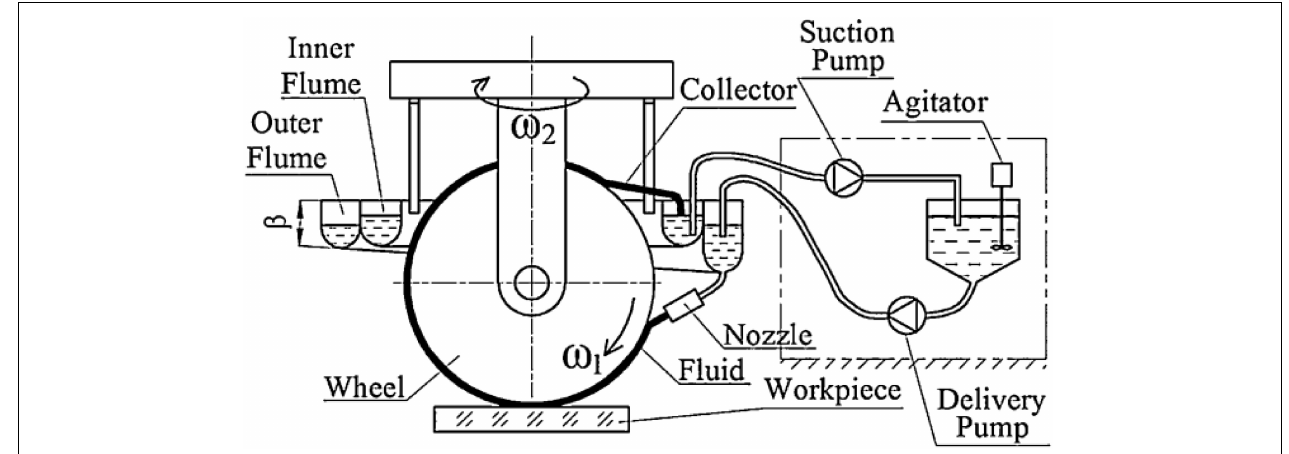
FIGURE 8 | The circulatory subsystem of DRMRF tool (Wang Y. Y. et al., 2016).